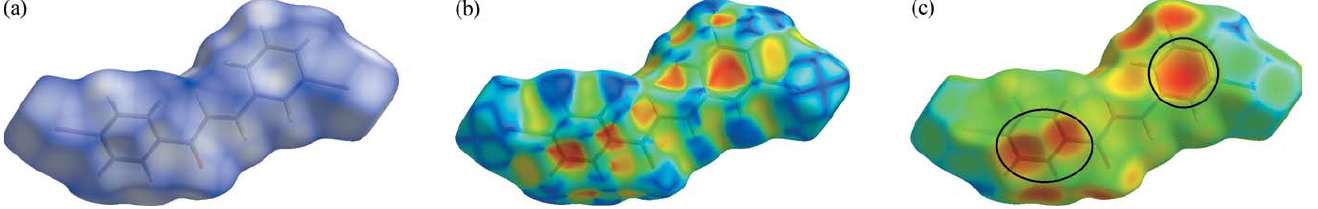
Figure 4 Hirshfeld surfaces of the title compound, mapped with ( a ) d norm , where white regions represent interactions equal to, and blue regions represent interactions shorter than the sum of their van der Waals radii, ( b ) the shape-index, and ( c ) d e , where the circled areas indicate the C—H (cid:3)(cid:3)(cid:3) (cid:3)